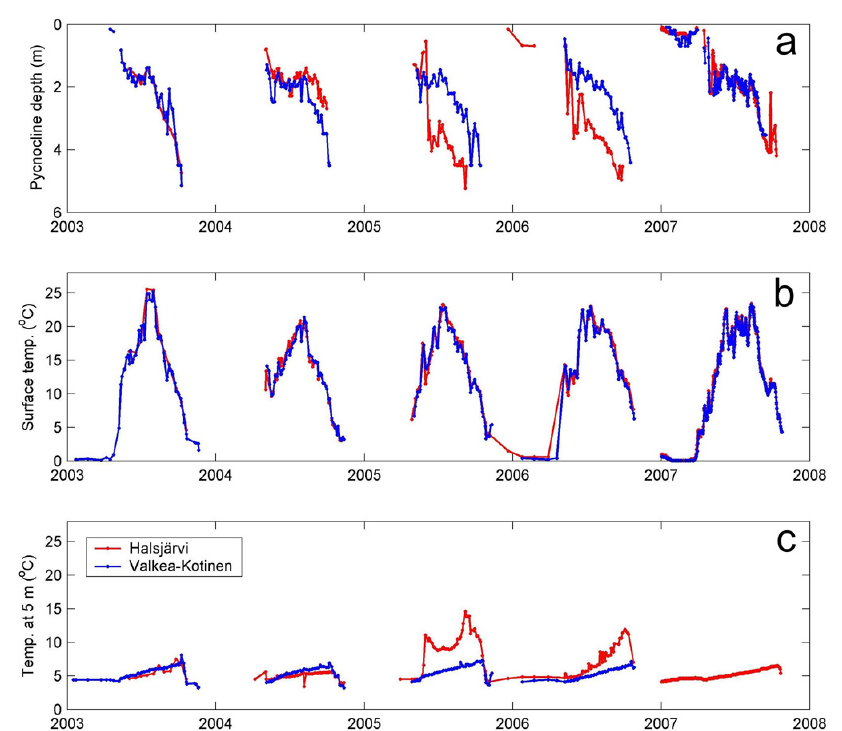
Fig. 4. Seasonal development of (a) pycnocline depth as well as (b) surface and (c) near bottom (5m) temperatures in lakes Halsj¨arvi and Valkea-Kotinen. The artificial mixing (lake manipulation experiment) was conducted in Halsj¨arvi in 2005–2006. Observations are denoted by